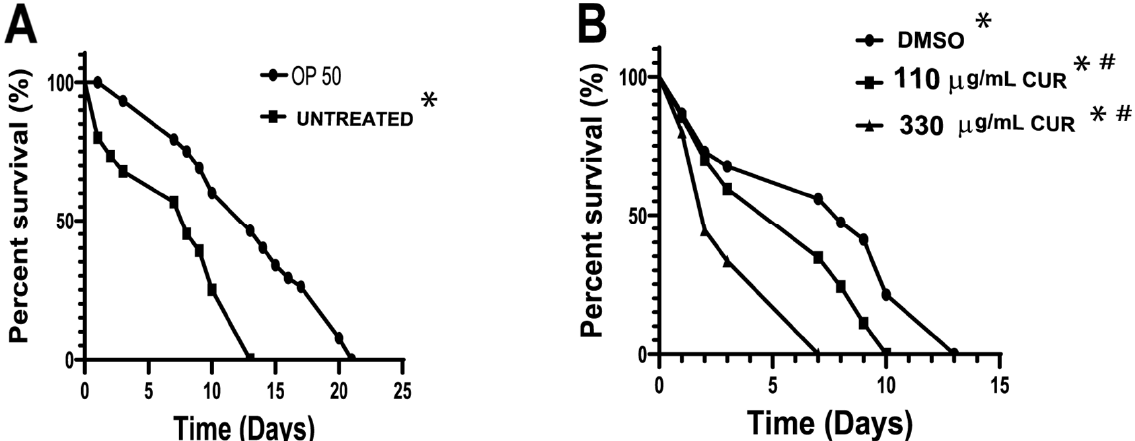
Figure 6. Lifespan of C. elegans infected with S. enterica ser. Typhimurium strain treated with 110 and 330 µ g/mL of CUR ( A ). Survival curves for nematodes fed with S . Typhimurium and Escherichia coli OP50. ( B ) Life expectancy of nematodes fed with S . Typhimurium pretreated with DMSO, 110 and 330 µ g/mL. Kaplan–Meier survival curves for S. enterica ser. Typhimurium. Survival percent are based on data from pathogenicity assay. Data were analyzed by log rank test, and all pairwise multiple comparison procedures used the Holm–Sidak method. n = 90, * P < 0.001 in relation to the OP50 and # P < 0.001 regarding the Untreated.